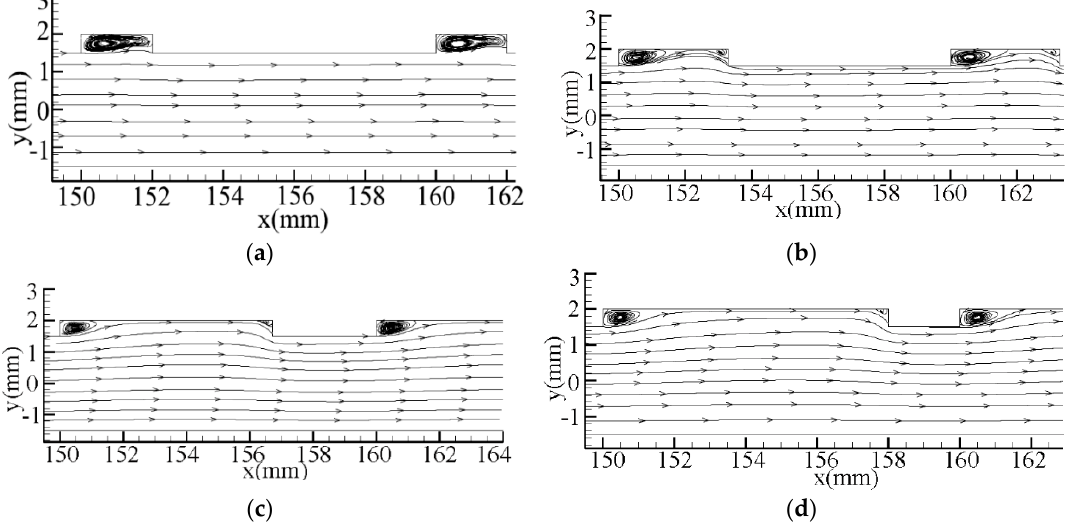
Figure 9. Flow patterns in a narrow channel under a constant L u of 10 mm, H of 0.5 mm and different R (Re = 3750). ( a ) 1:4, ( b ) 1:2, ( c ) 2:1, ( d ) 4:1.